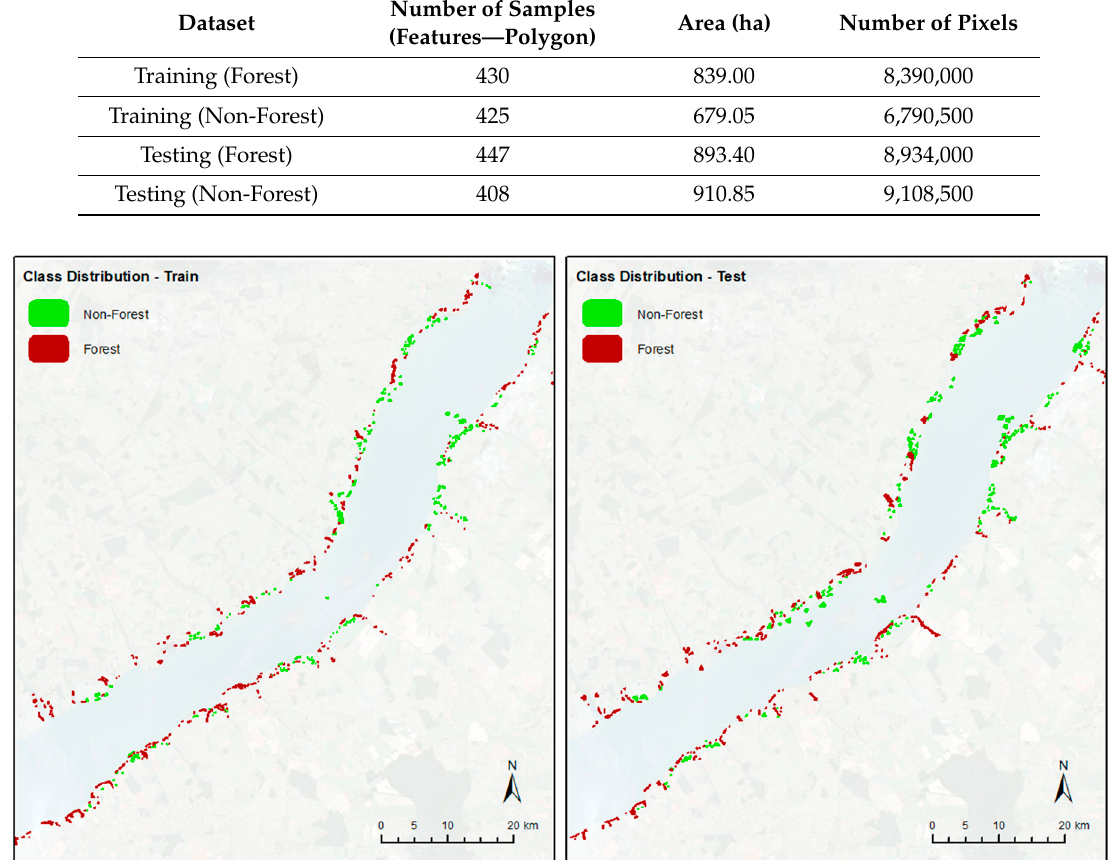
Table 2. Description of the training, validation, and testing sets of the dataset.